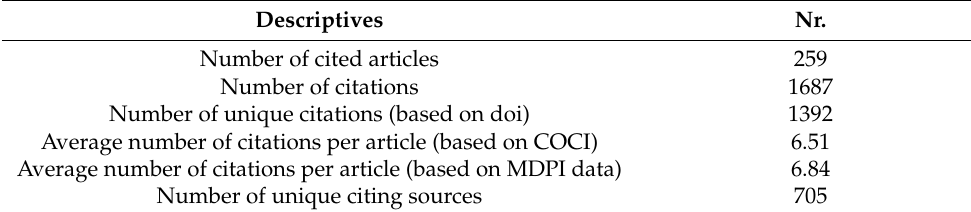
Table 7. Descriptives of the knowledge flow based on